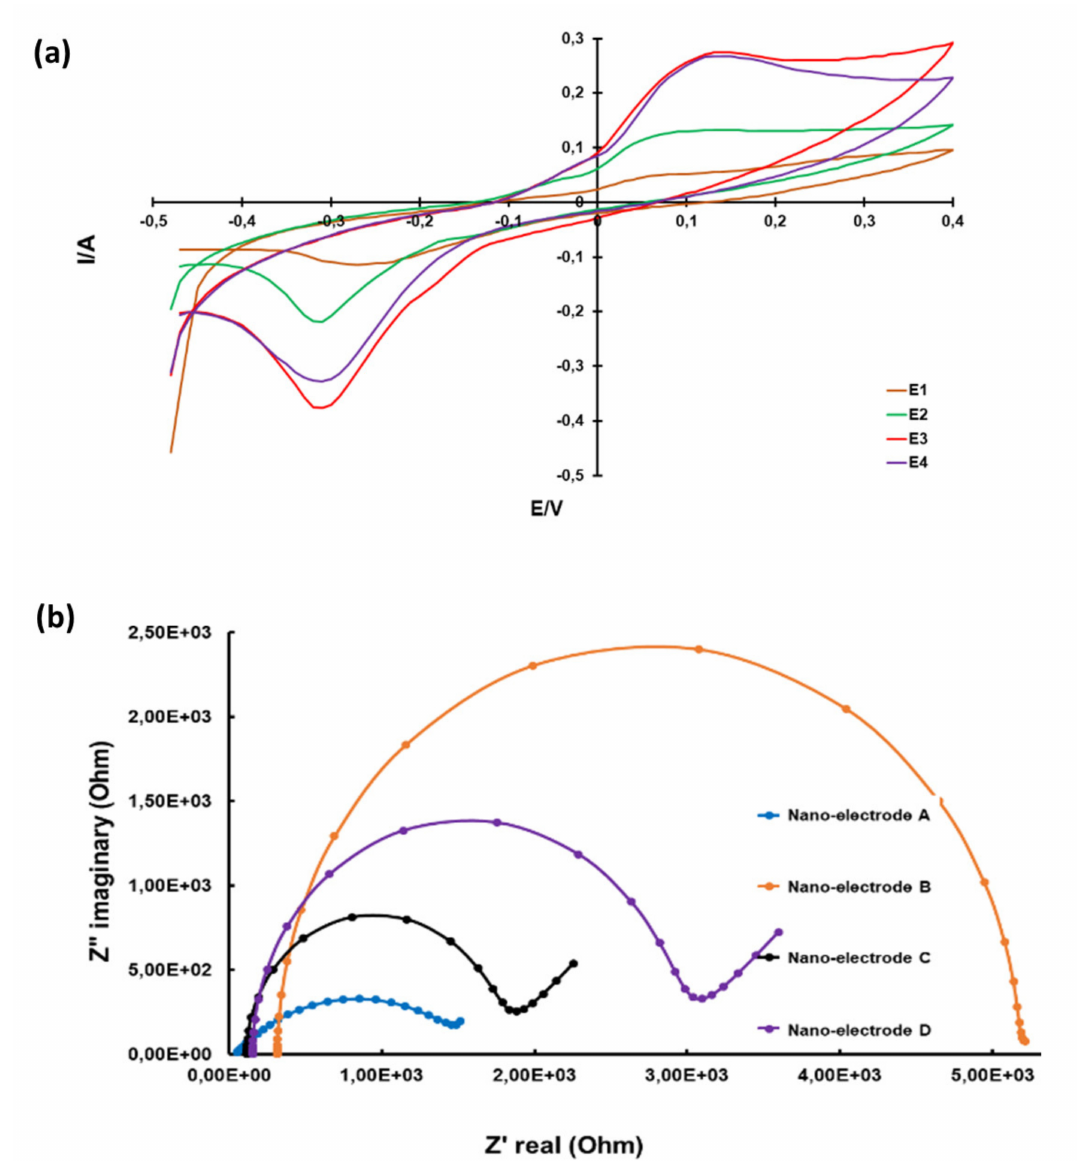
Figure 8. Electrochemical properties of MWCNTs. Cyclic voltammographs of nanoelectrodes ( a ). Nyquist impedance plots of nanoelectrodes ( b